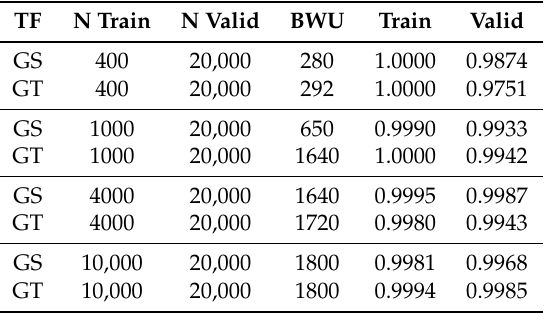
Table notation: TF—Time-frequency representation. N train and N valid—Number of samples in training and validation sets. BWU—Weight update after which the highest performance was achieved on the validation set. Train and valid—accuracy on training and validation sets.